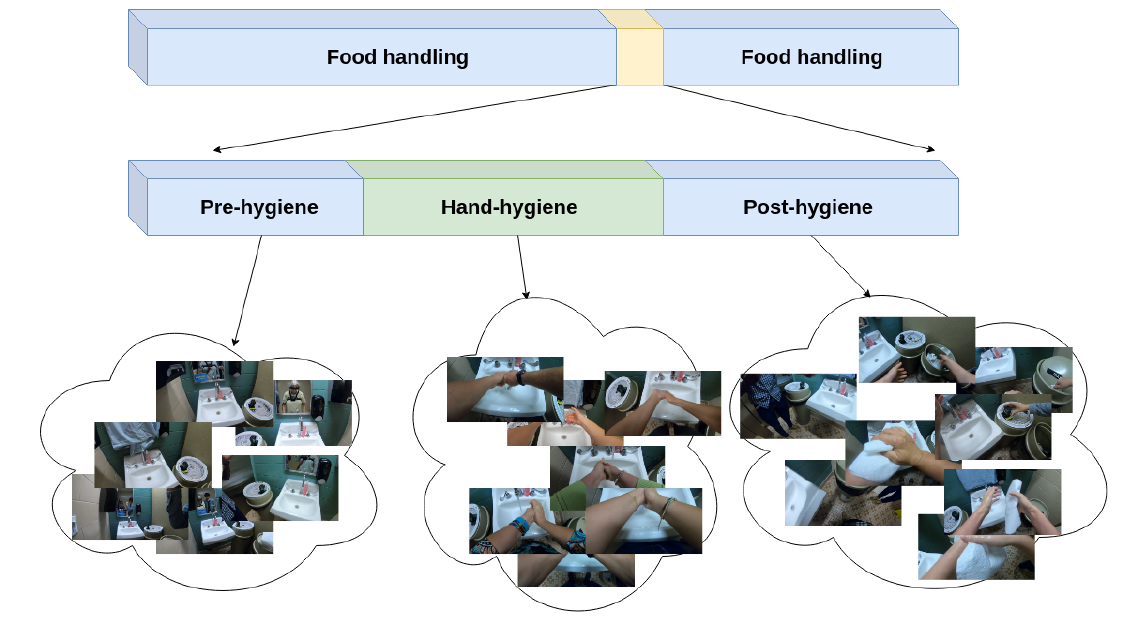
Figure 2. Hand-hygiene periods in untrimmed